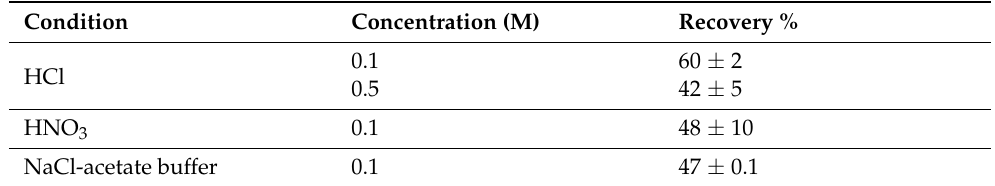
Table 3. Percentage of total platinum recovery by desorption.